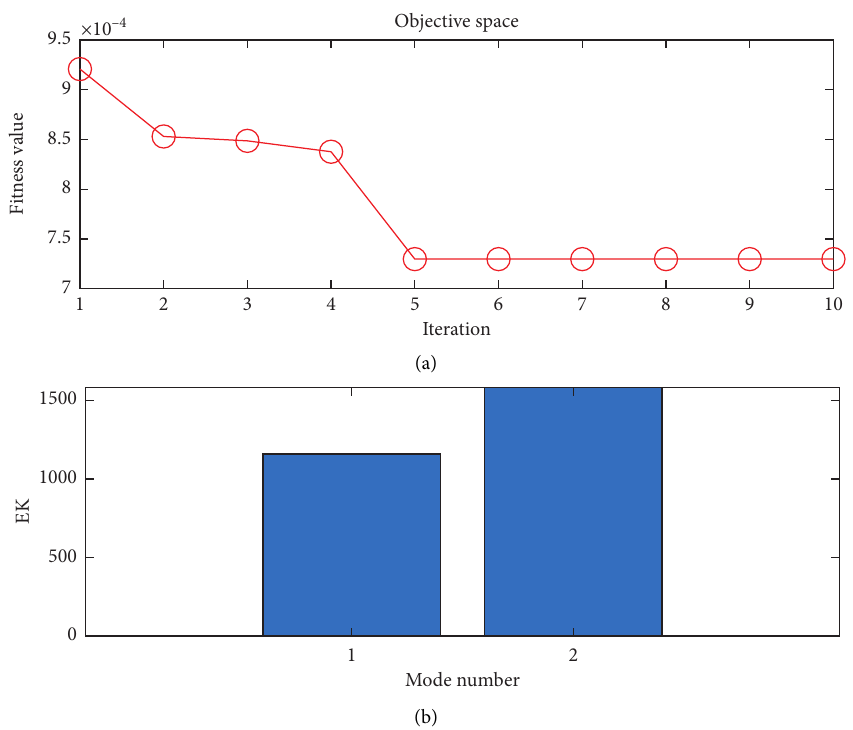
Figure 31: Experimental signals of case 2: the optimization process based on PAVMD: (a) PSO convergence curve and (b) the EK value of each